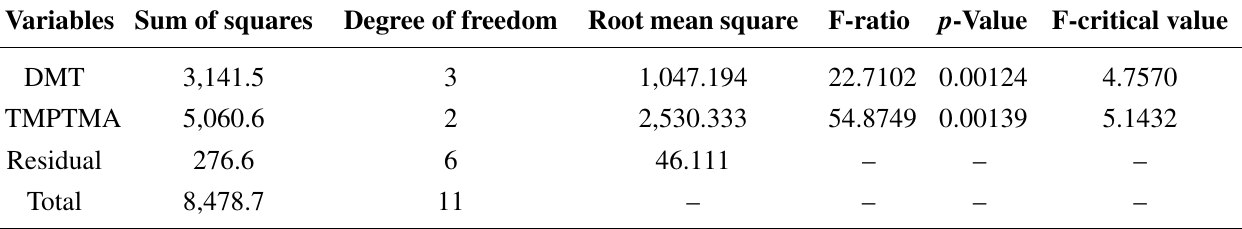
Table 5. Two-way ANOVA for working life of acrylic polymer concrete cured at ´ 20 ˝ C. Variables Sum of squares Degree of